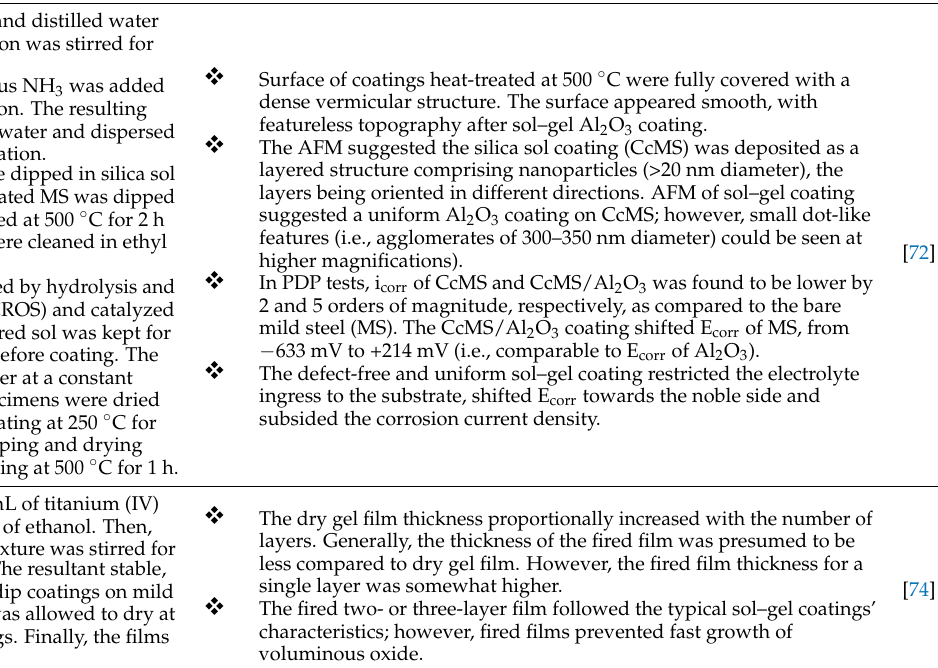
Table 1. Different approaches for improving silane coatings and the main findings, as reported in the literature. Silane(s) Used Coating Preparation Main Findings Ref.